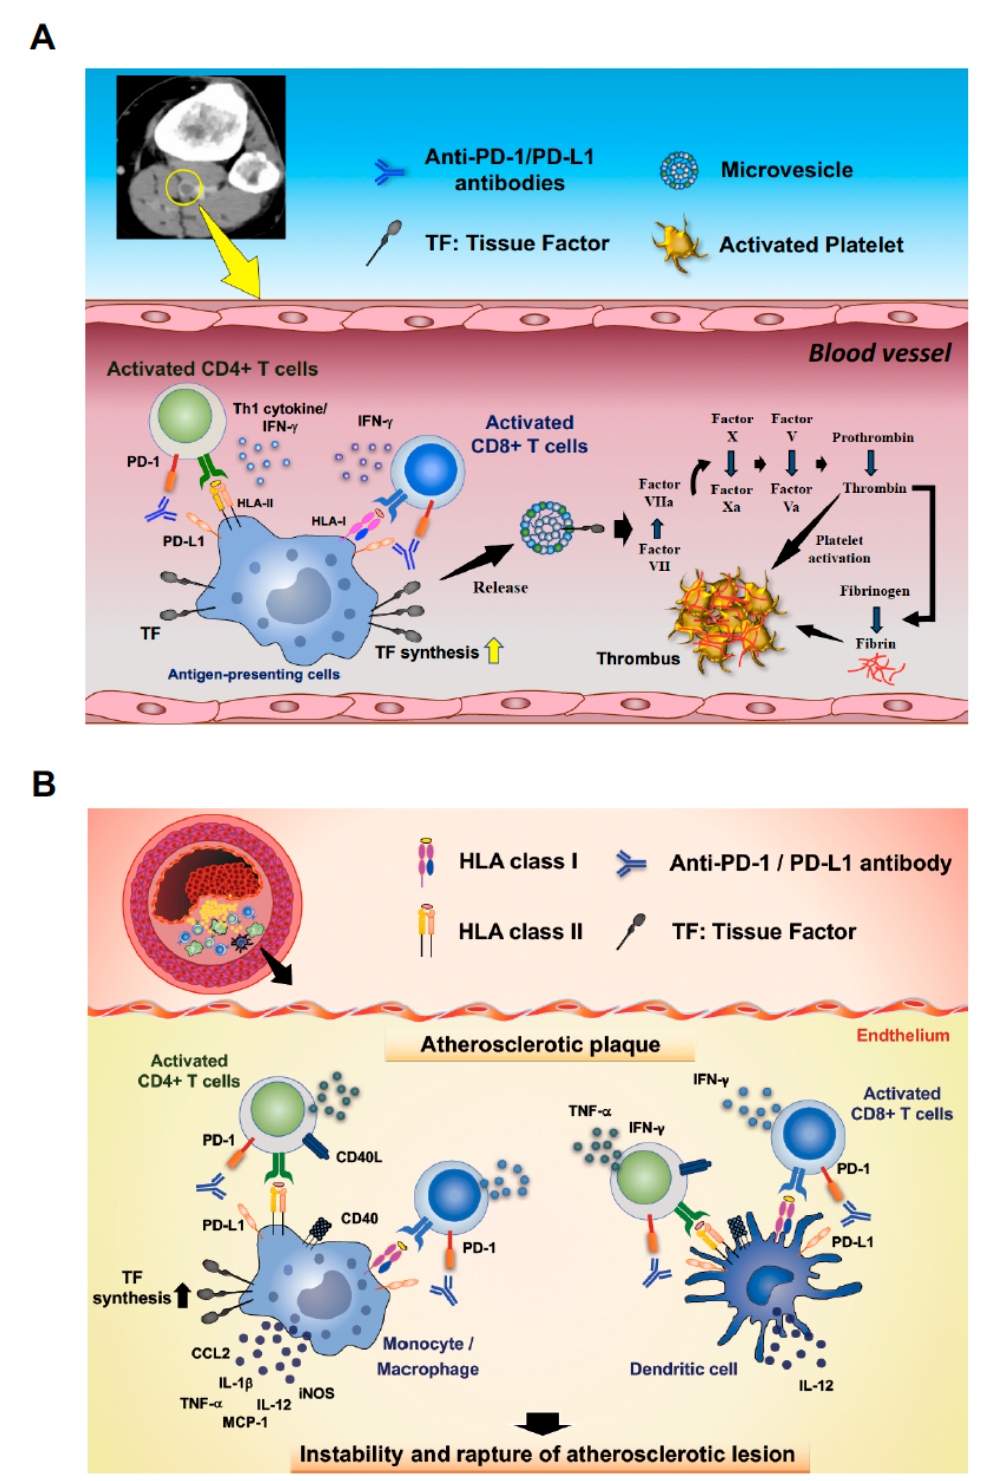
Figure 6. Hypothetical mechanisms of the onset of disorders of coagulation-fibrinolysis triggered by ICIs based on the current study and references. ( A ) The crosstalk between APCs and T cells provides crucial stimulatory signals for efficient expansion and development of effector functions to T cells. ICIs promote T cell activation by blocking the interaction between PD-1 and PD-L1 and induces IFN- γ and Th1 cytokine production, which play a crucial role in anti-tumoral effects. In turn, the IFN- γ and Th1 cytokines promote APC activation and TF synthesis in monocytes/macrophages. TF-